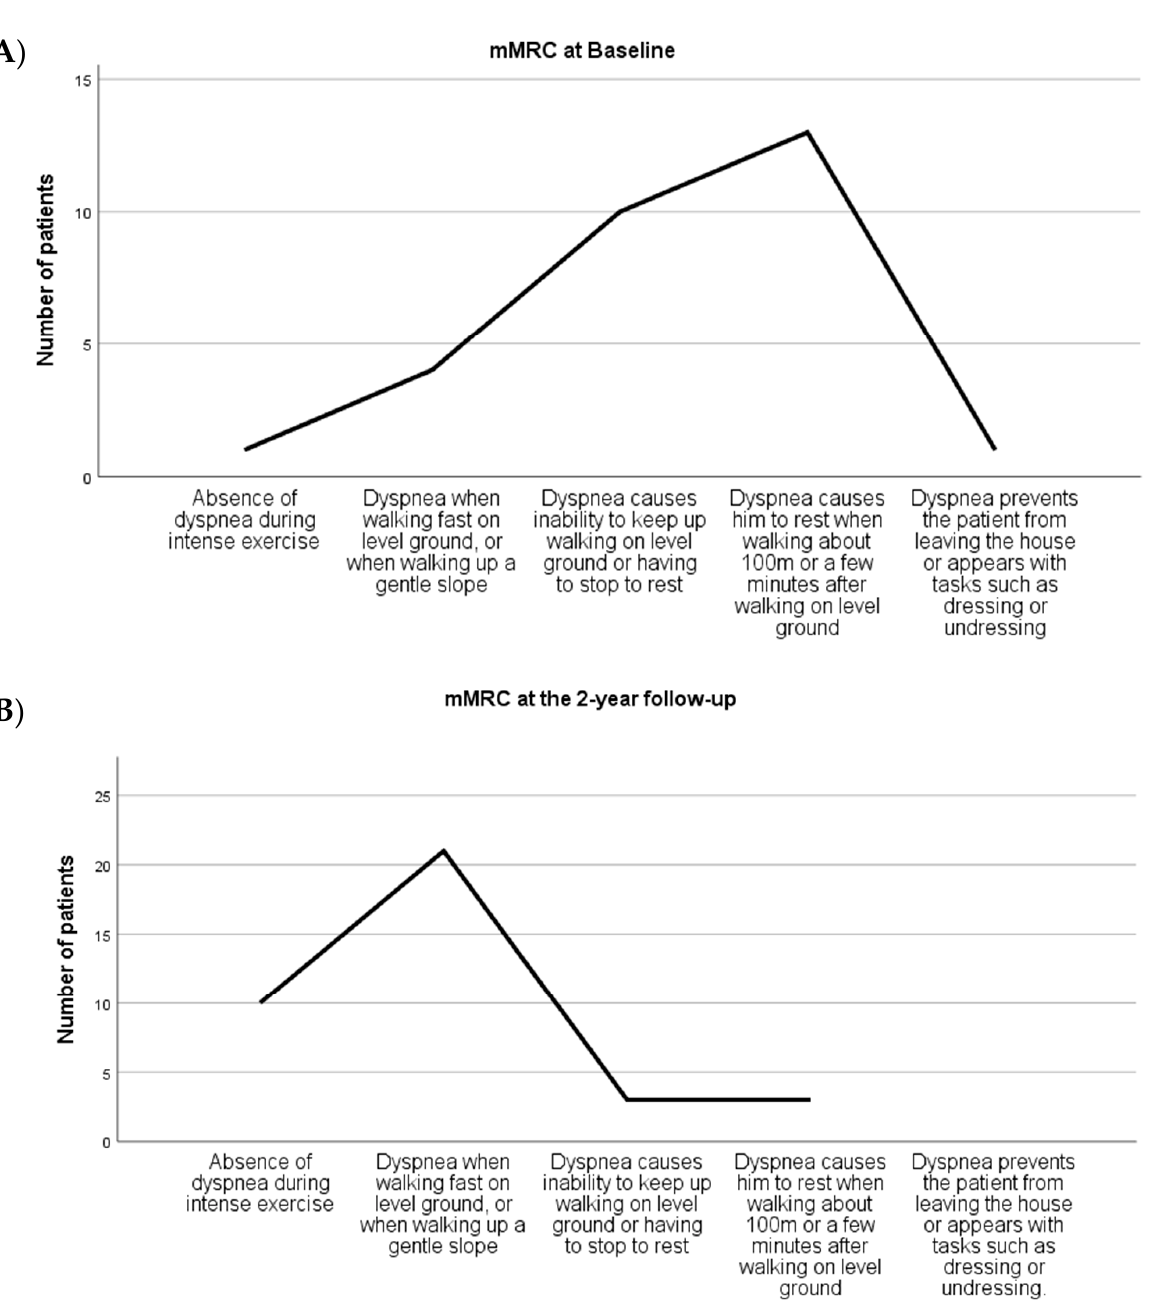
Figure 4. ( A ) Graphic of the results of the Medical Research Council dyspnea scale at Base- line. ( B ) Graphic of the results of the Medical Research Council dyspnea scale at the 2-year follow-up